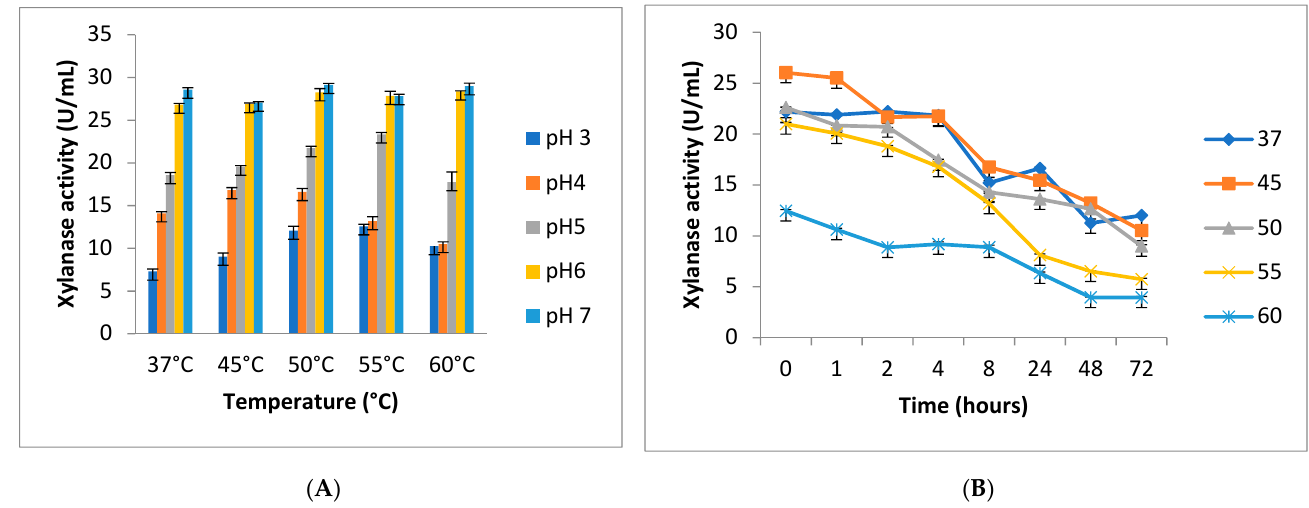
Figure 5. ( A ) Effect of temperature and pH on xylanase activity from Aspergillus niger LPB-334. ( B ) Thermoresistance of xylanase activity from Aspergillus niger LPB-334. The error bars represent standard deviations. The averages of results of three independent experiments, each one performed with three biological replicates, are reported.